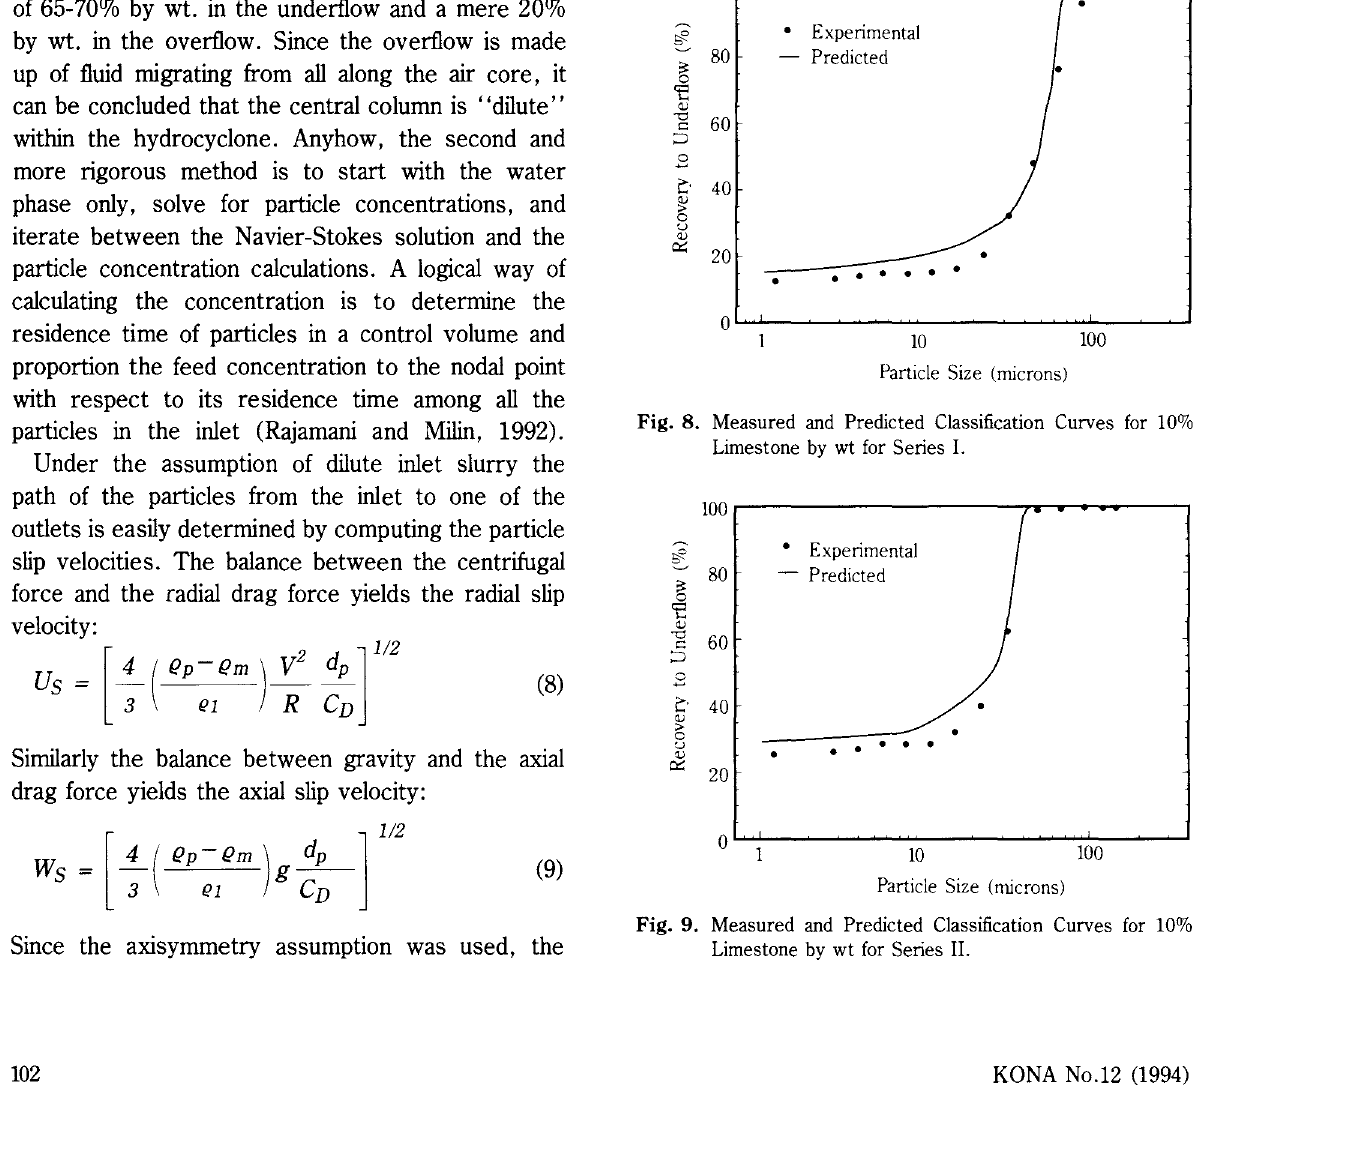
Fig. 9. Measured and Predicted Classification Curves for lOo/o Limestone by wt for Series